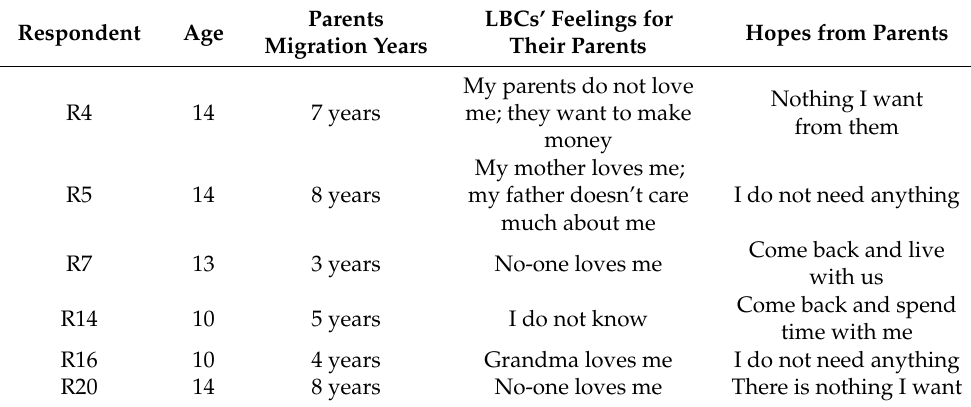
Table 6. LBCs’ parental attachment during